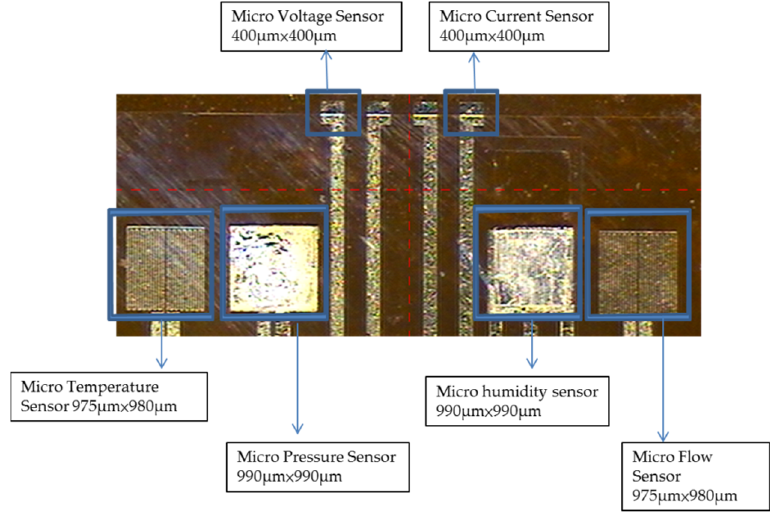
Figure 8. Optical micrograph of flexible six-in-one microsensor.